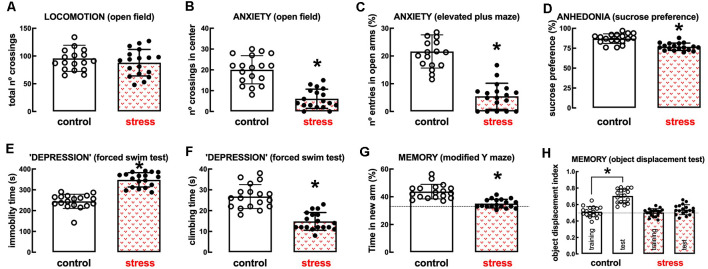
Male adult Wistar rats (8–10 weeks old) subject to a protocol of restraint stress (4 h/day) during 14 days display the expected features of depressed rats. Compared with non-stressed control rats (open bars), stressed rats (red checkered bars) displayed a preserved locomotor activity as evaluated in the open field (A), anxiety-like behavior as evaluated in the open field (B), and in the elevated plus-maze (C) tests, anhedonia as evaluated in the sucrose preference test (D), helpless-like behavior as evaluated by the forced-swimming test (E,F) and impaired memory performance as evaluated by a modified Y maze test (G) and an object-displacement test (H). Data are shown as mean ± SEM; n = 16–18 rats per group. *P < 0.001 using a Student’s t-test.